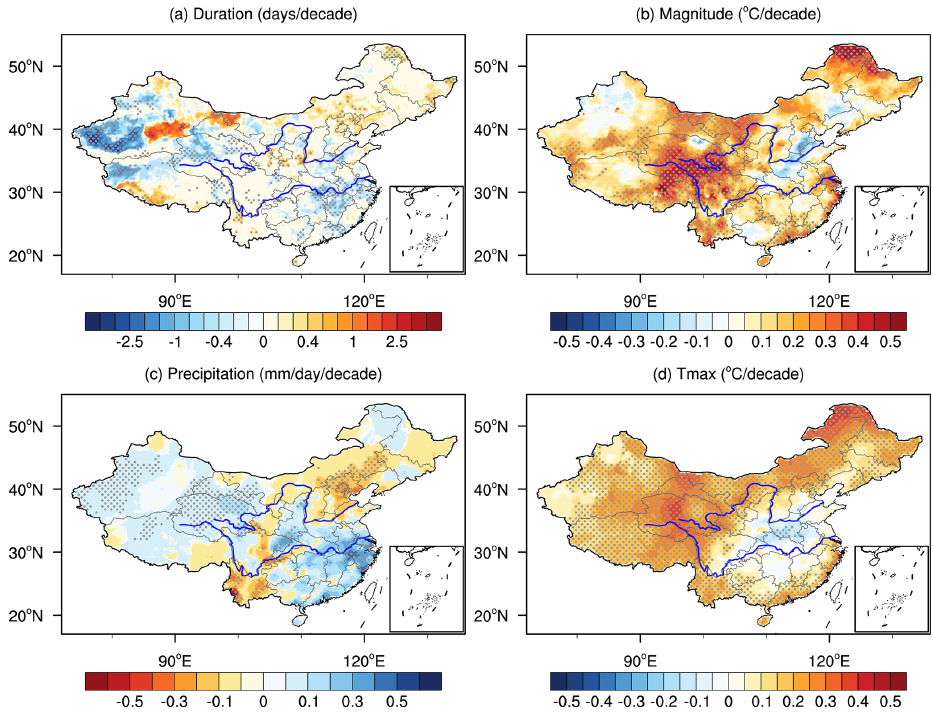
Figure 5. Decadal trends for the summer maxima of (a) duration and (b) magnitude during 1961–2014. Trends for summer mean (c) precip- itation and (d) Tmax. Stippling indicates significance at the 90% confidence level.